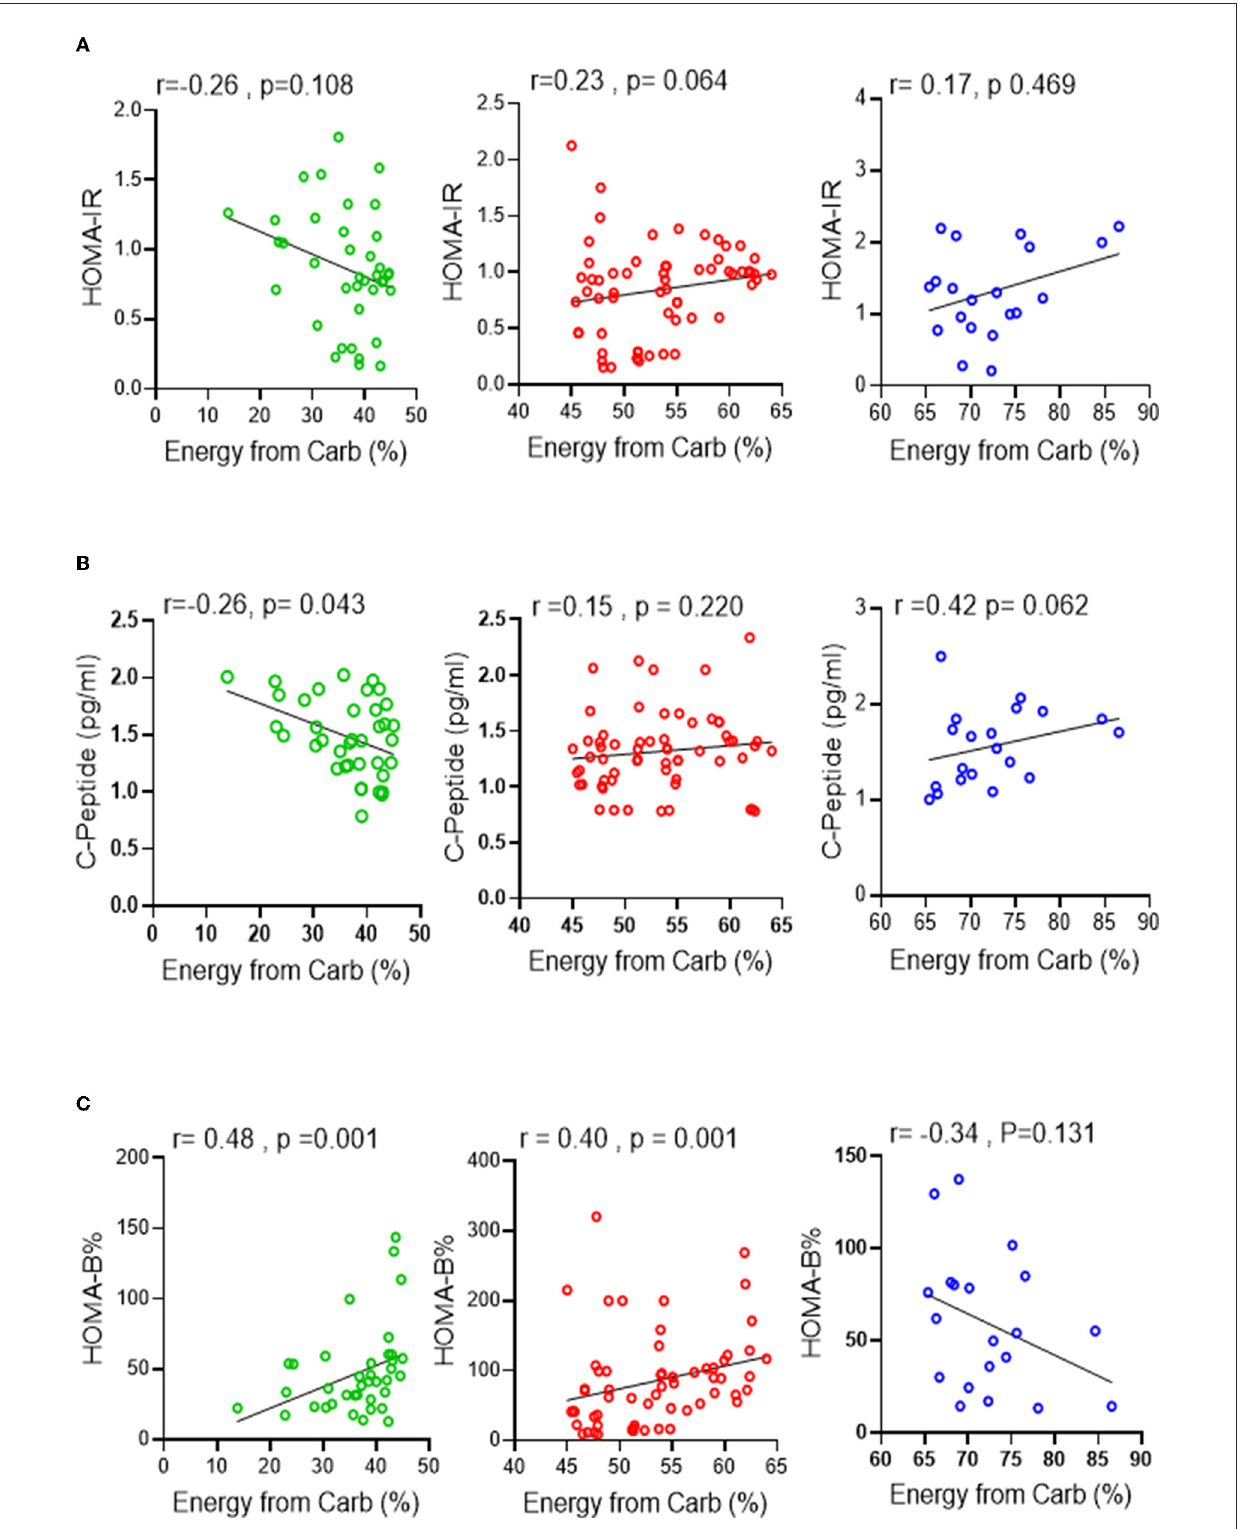
FIGURE2 Association between carbohydrate intake levels and glucose homeostasis. Spearman correlation test was conducted to investigate the association between (A) HOMA-IR, (B) C-peptide secretion and (C) HOMA- β % and the level of carbohydrate intake % of energy in all three groups. All data are expressed as mean ± SD. P ≤ 0.05 was considered statistically significant. Low Carbohydrate intake ( < 45% energy from carb; green), Recommended range of carbohydrate intake (45–65% energy from carb; red), High carbohydrate intake ( > 65% energy from carb;